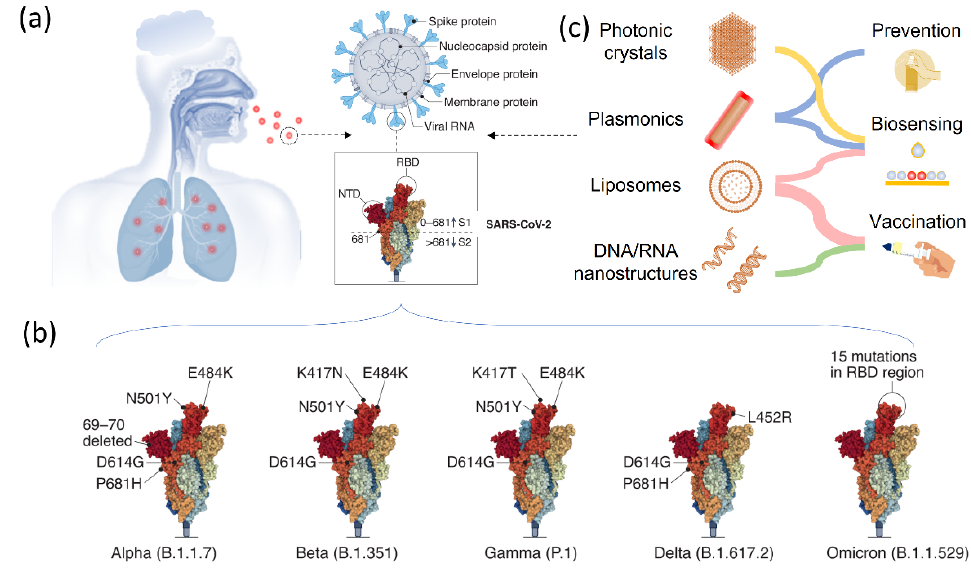
Figure 1. Smart nanostructured materials for SARS-CoV-2 and variants biosensing, treatment, and vaccination. ( a ) Scheme of smart nanostructured materials for COVID-19 treatment. ( b ) The structure of SARS-CoV-2 and the major components, including the S protein, nucleocapsid protein, envelope protein, membrane protein and viral RNA. ( c ) SARS-CoV-2 variants of concerns. Reprinted from [30], with permission from Springer Nature (Berlin/Heidelberg, Germany).